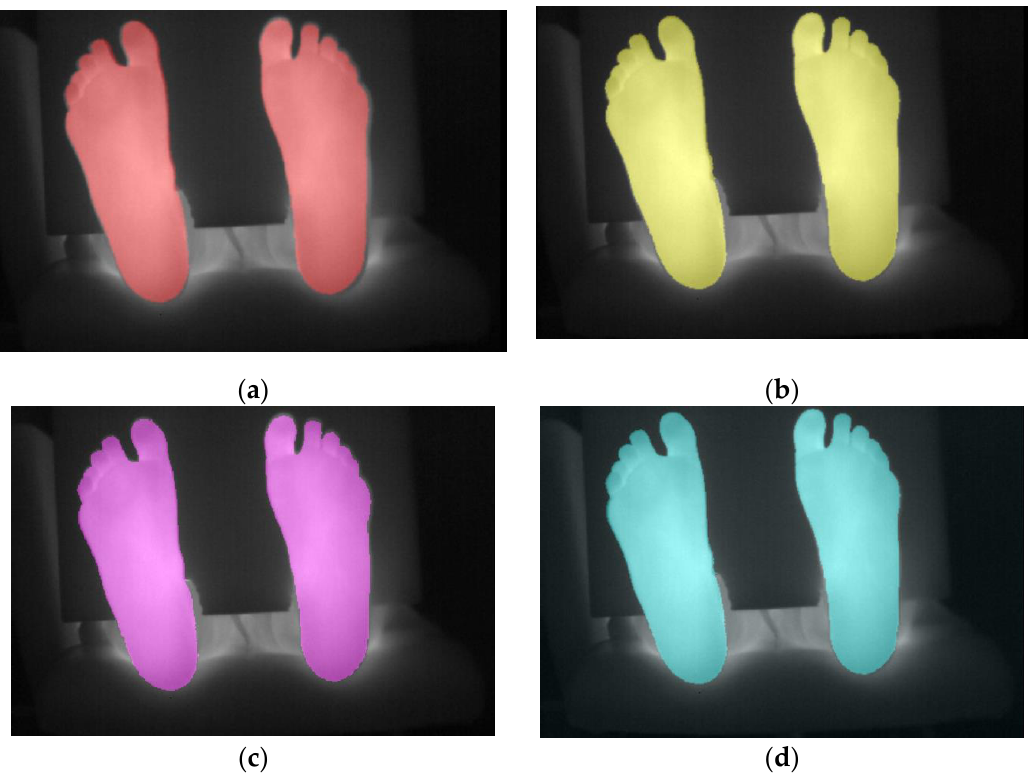
Figure 2. Fusion of thermal IR images with the feet segmentation of the visible image after applying each registration method (masks highlighted in color) analyzed at 800 mm. ( a ) GOT, ( b ) Homography, ( c ) ICP, and ( d ) Affine-ASGD registration methods.